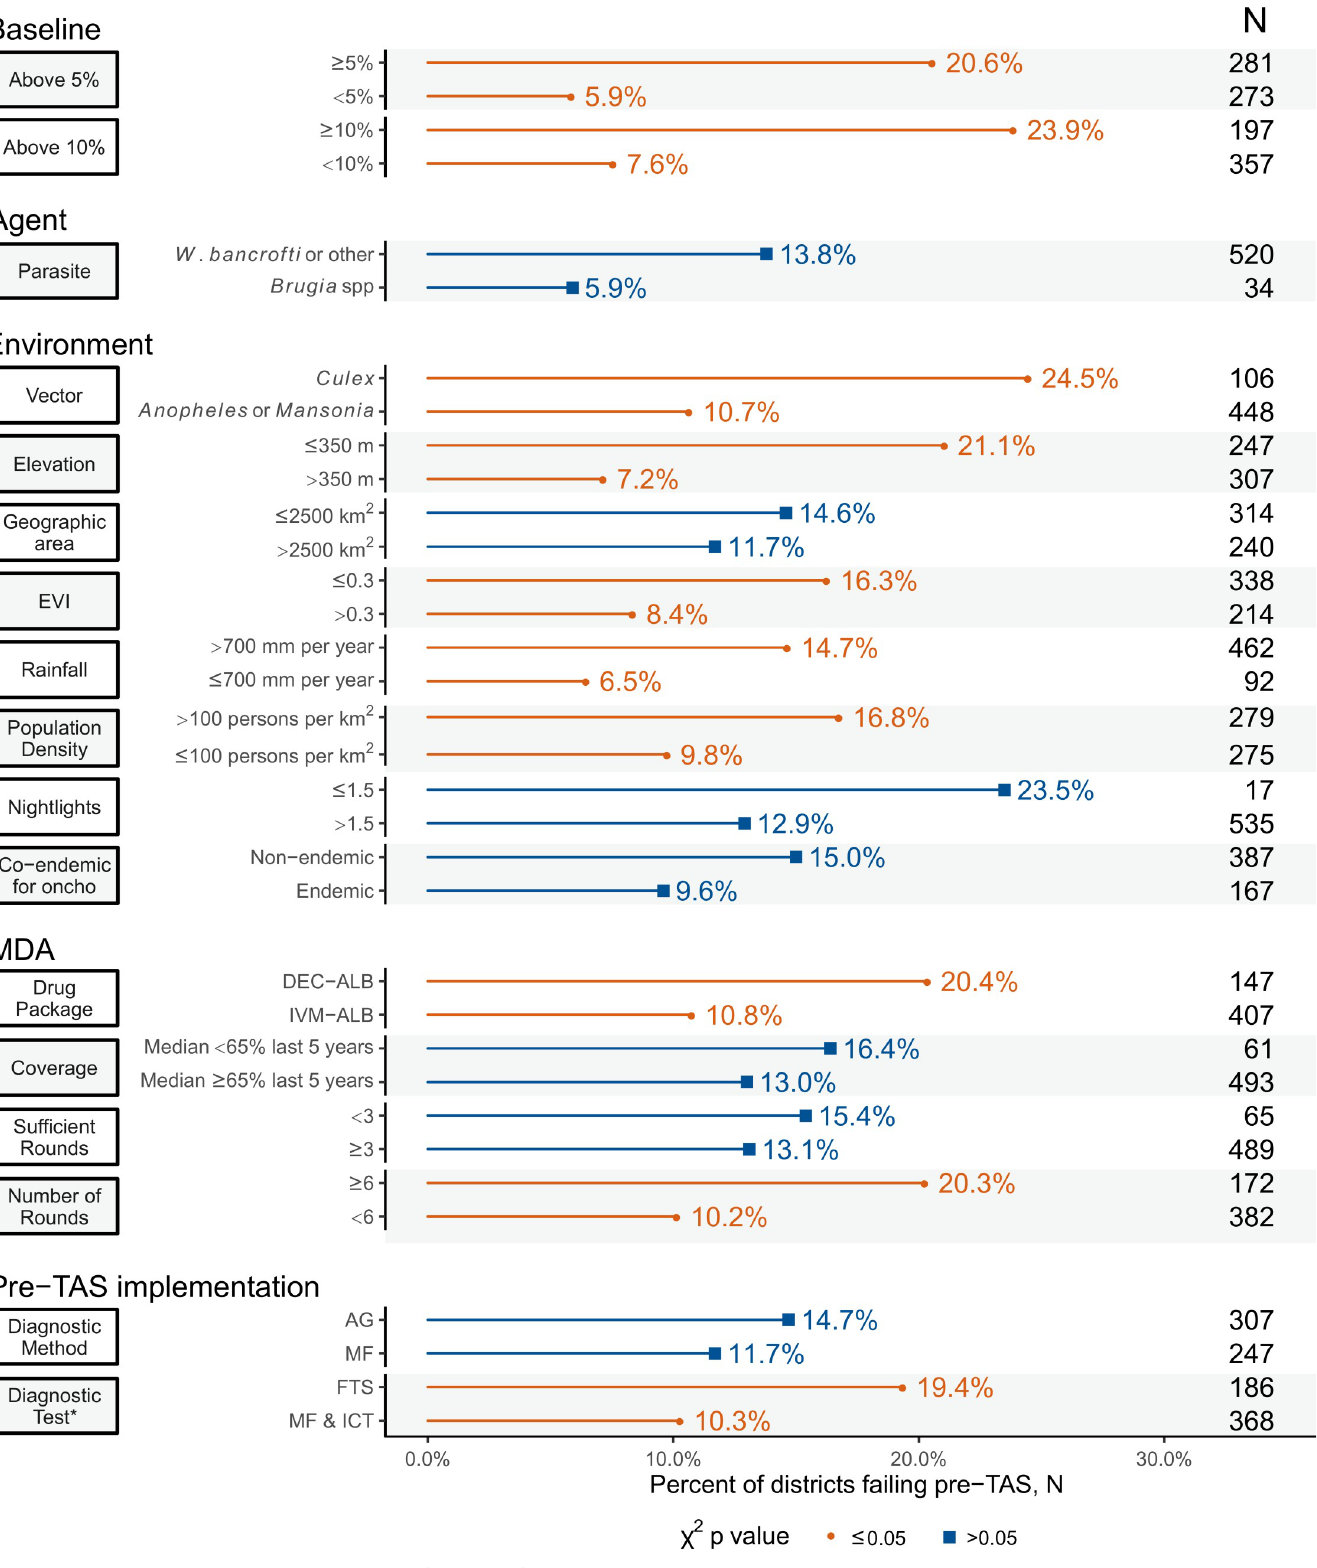
Fig 3. Percent pre-TAS failure by each characteristic (unadjusted).